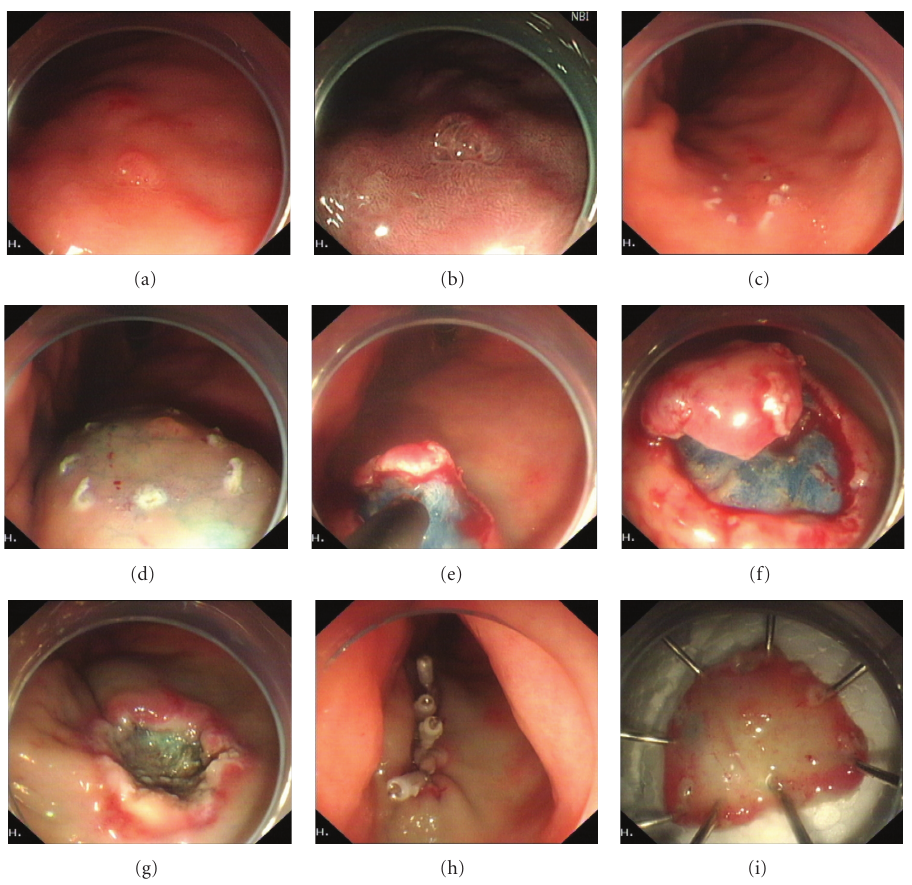
Figure 1: The procedure of endoscopic submucosal dissection for a gastric neuroendocrine tumor. (a, b) A sessile polyp with a reddened surface of the gastric body. (c) Making. (d) Injection. (e, f) Dissection. (g) Resultant artificial ulcer. (h) Closure of the defect with metallic clips. (i) Completely resected